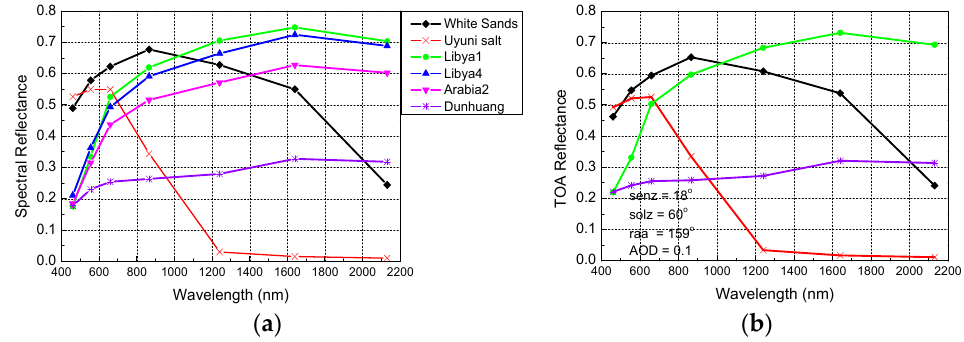
Figure 3. ( a ) Averaged spectral reflectance curves of the stable sites acquired from MODIS BRDF products in the year of 2010 and ( b ) TOA reflectance calculated from 6SV by using the averaged spectral reflectance curves under the following viewing geometries: sensor zenith angle (senz) of 18°, solar zenith angle (solz) of 60°, relative azimuth angle (raa) of 159°, and atmospheric condition aerosol optical depth (AOD) of 0.1.